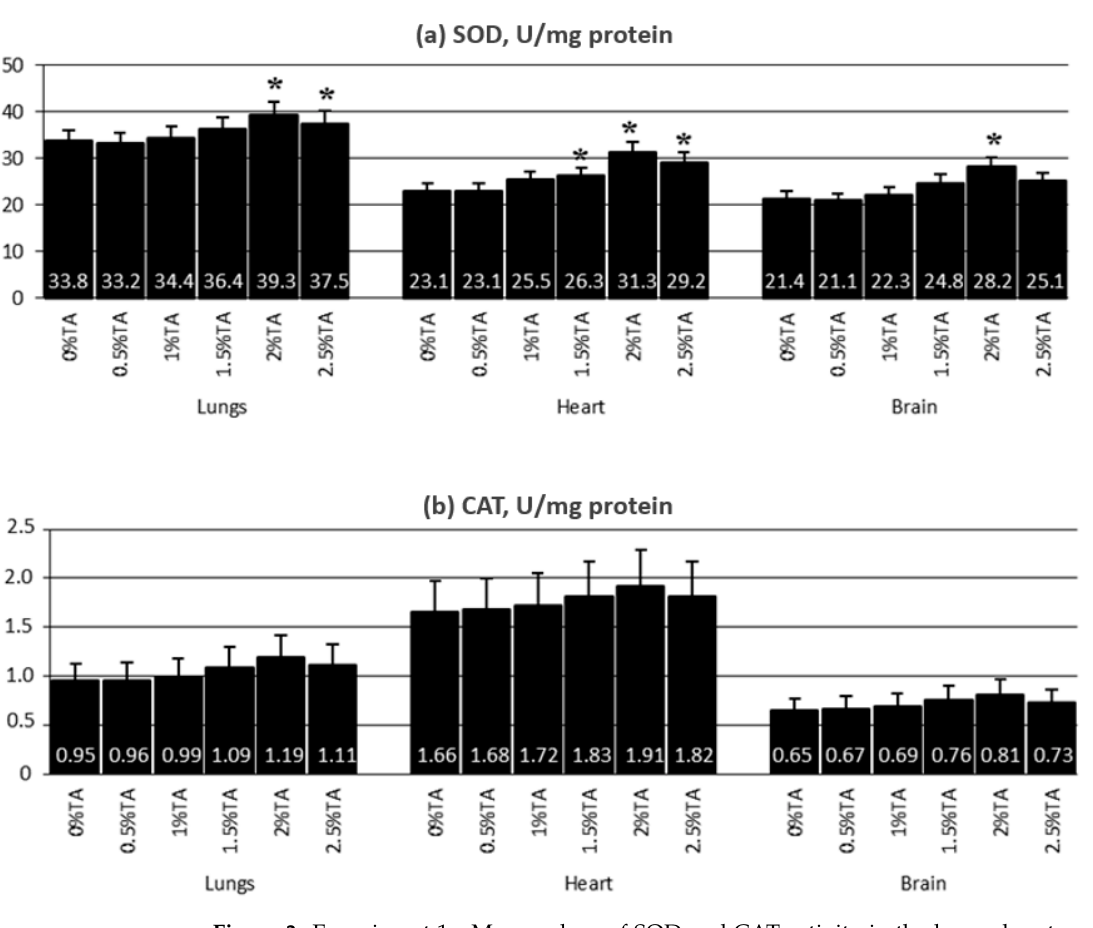
Figure 3. Experiment 1—Mean values of SOD and CAT activity in the lungs, heart and brain for 12 weeks of exposure (mean ± SD), U/mg protein. SD—standard deviation; * significant versus 0% TA ( p < 0.05).